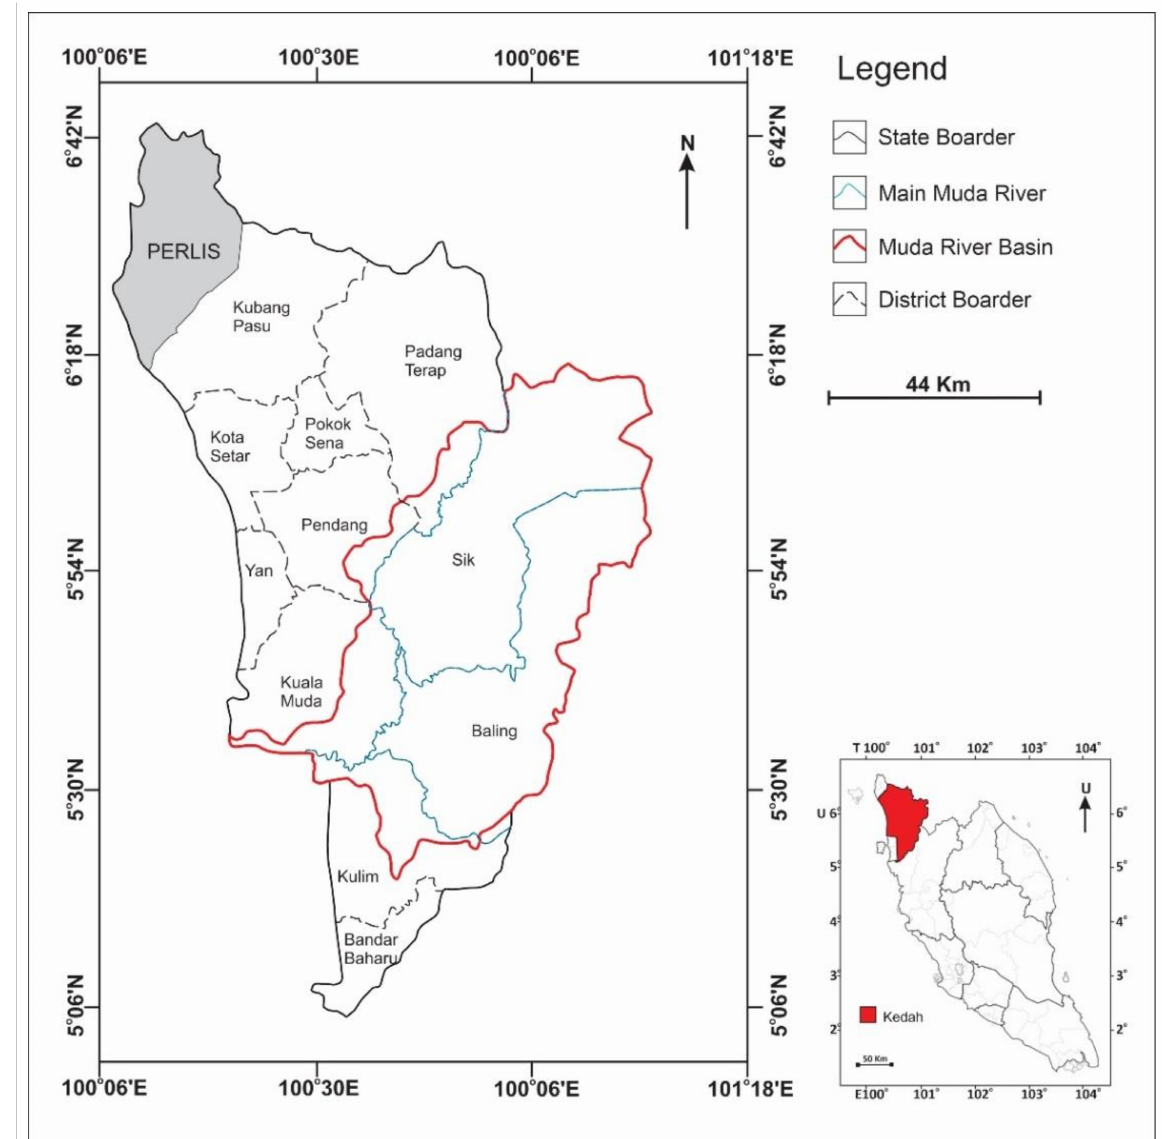
Figure 1. The Muda River basin is shown bordered in red. The Muda River is the natural geographical border of at least four major districts in Kedah which are Sik, Baling, Kuala Muda and